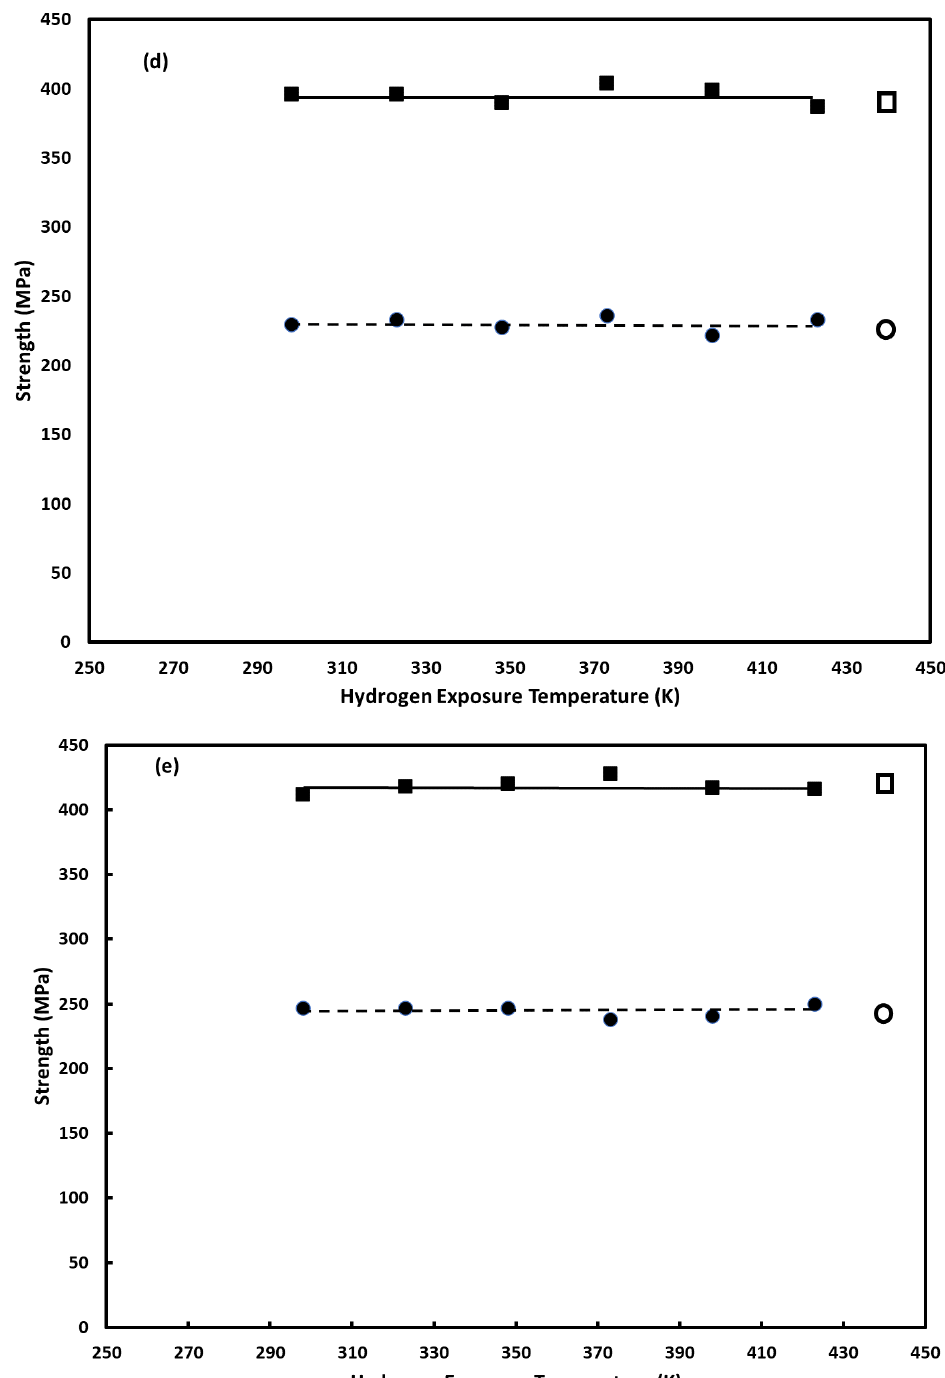
Figure 2. Yield Strength (●) and ultimate strength ( ■ ) as a function of hydrogen absorption/desorption cycling temperature: ( a ) palladium – copper (5 wt.% Cu); ( b ) palladium – copper (10 wt.% Cu); ( c ) palladium – copper (15 wt.% Cu); ( d ) palladium – copper (20 wt.% Cu); ( e ) palladium – copper (25 wt.% Cu). For comparison, yield strength ( ○ ) and ultimate strength (□) of vacuum-annealed specimens are included and positioned at an arbitrary temperature.